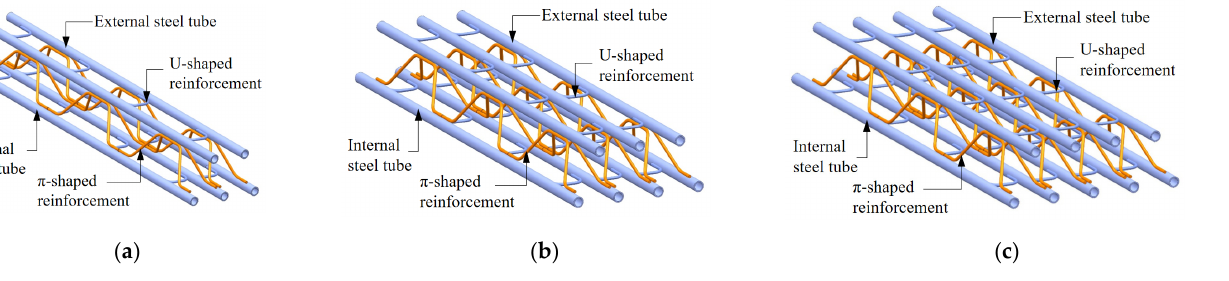
Figure 4. Structural types of the SRS arch: ( a ) five-leg, ( b ) seven-leg, ( c ) nine-leg.